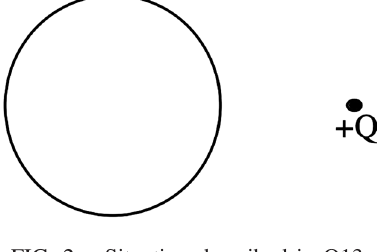
FIG. 2. Situation described in